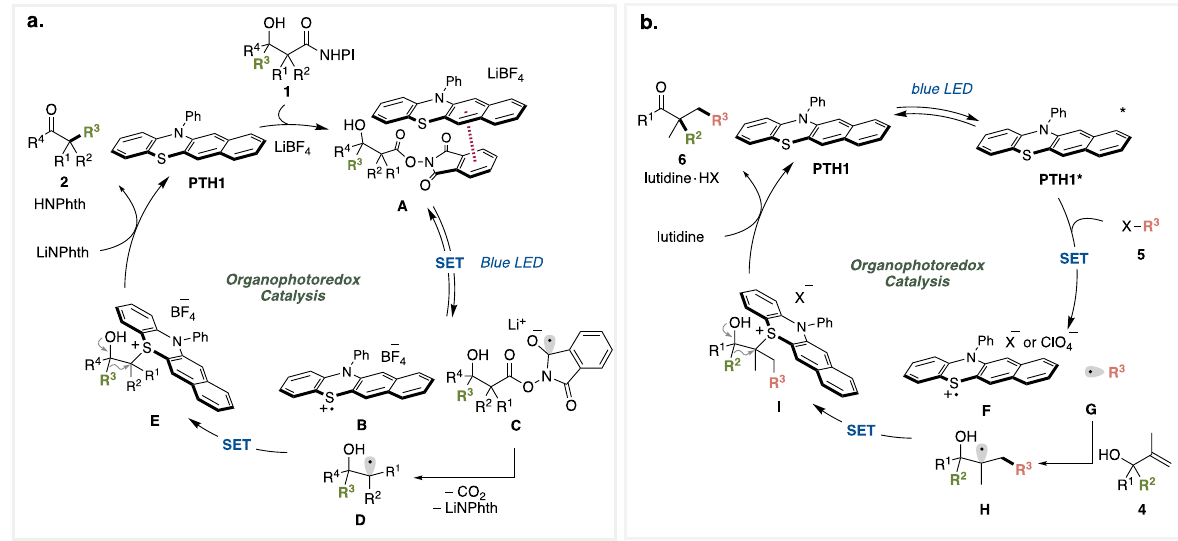
Fig. 4 Possible pathways. a A proposed catalytic cycle for decarboxylative semipinacol rearrangement. b A proposed catalytic cycle for alkylative semipinacol type